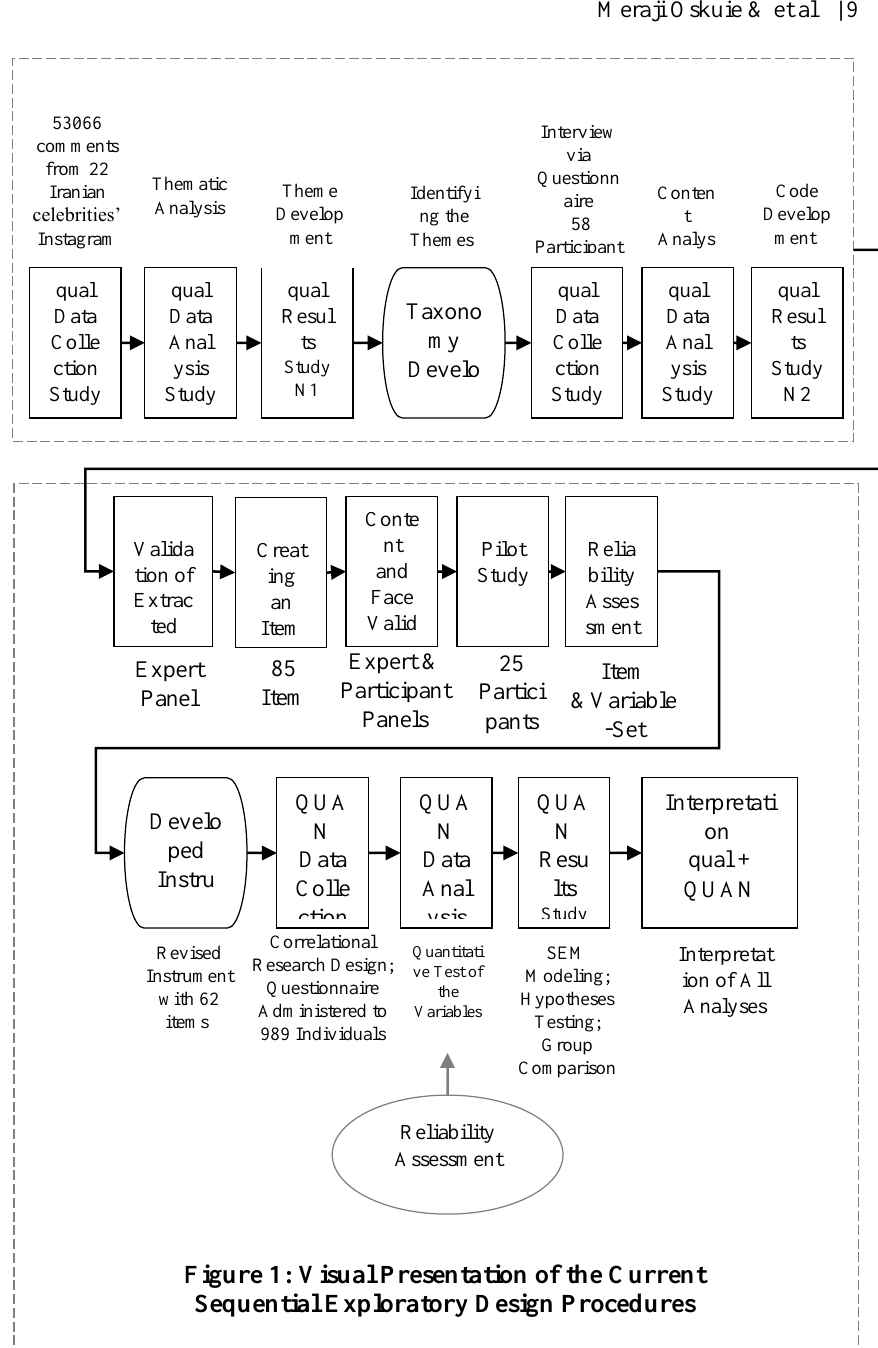
Figure 1: Visual Presentation of the Current Sequential Exploratory Design